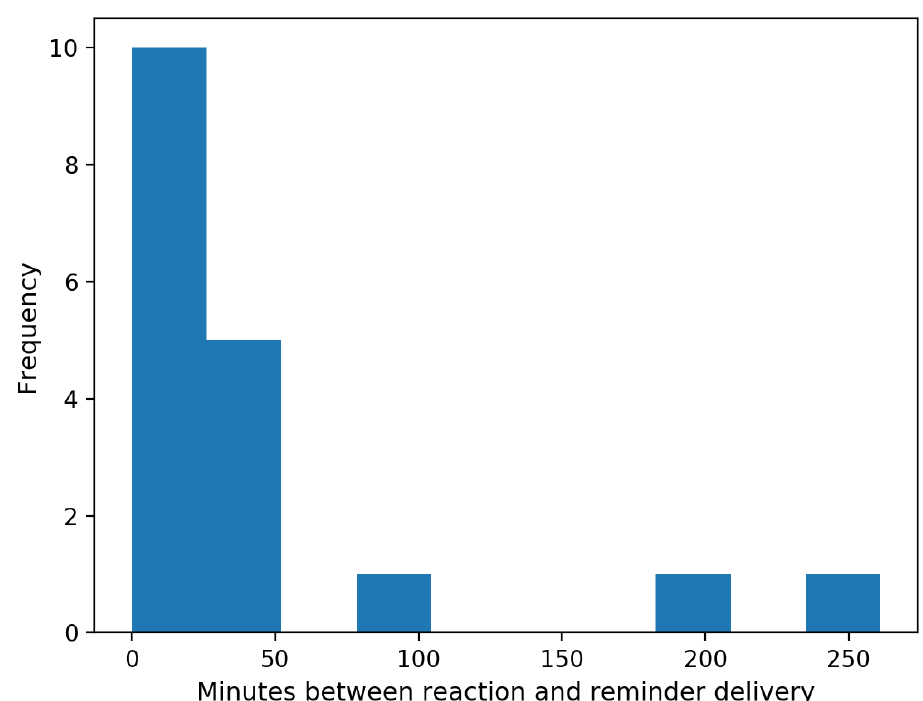
Figure 6. Distribution of the interval time between reminder delivery and reaction (when participants clicked a